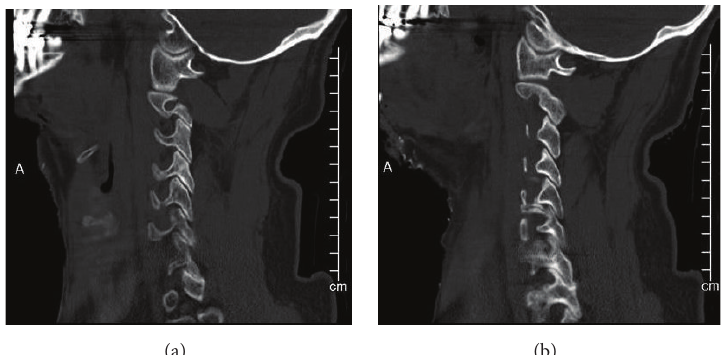
Figure 4: Right and left parasagittal cuts through the occipital-cervical junction demonstrating reduced occipital condyle-C1 and C1-C2 joints bilaterally. There is no evidence of distraction across these joints.